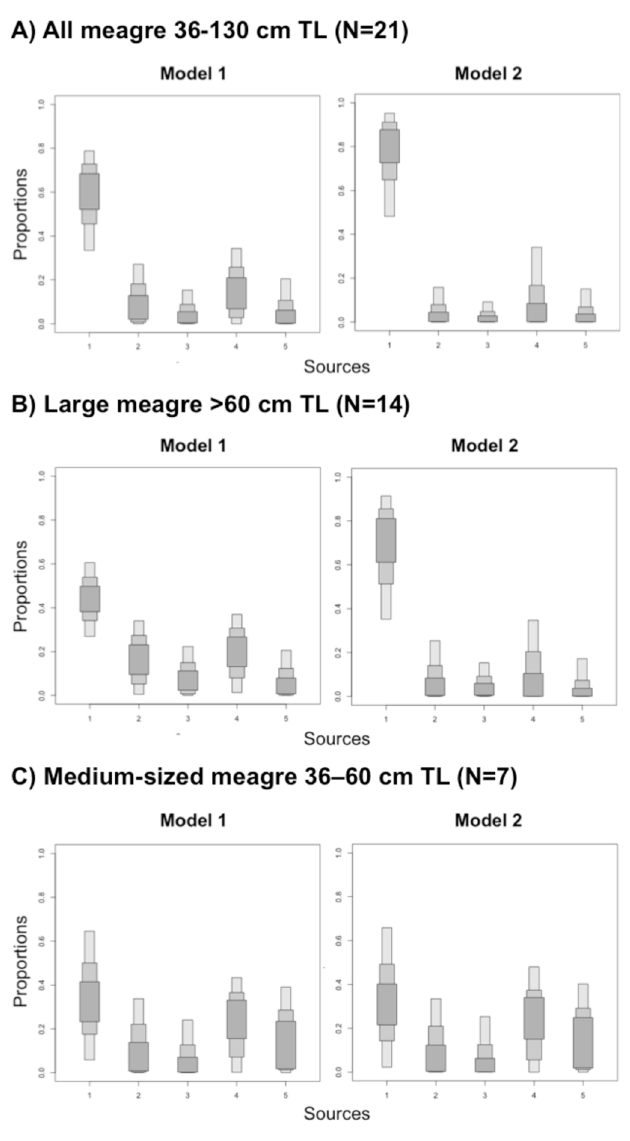
Fig. 5. Results of SIAR mixing models applied with different TEFs, showing the estimated proportions (with 50%, 75% and 95% con fi dence intervals) of each source/prey in the diet of meagre (size range =36 – 130 cm TL) collected in 2010 in the Bay of Biscay and analysed for SIA. Data corrected from the effect of ethanol preservation were used (see text and Supplemental Material). (A) Models applied on all individuals analysed for SIA ( N =21); (B) Models applied on large individuals only ( > 60 cm; N =14); Models applied on medium-sized individuals only (36 – 60 cm TL; N = 7). Prey groups (Spitz et al. , 2013): 1 =Pelagic fi sh; 2= Demersal and benthic fi sh; 3= Coastal fi sh; 4= Cephalopods; 5 =Crustaceans. TEFs: Model 1= 1.7± 1.1 ‰ for d 13 C and 3.2 ±1.3 ‰ for d 15 N (Sweeting et al., 2007a,b); Model 2= 2.5±0.1 ‰ for d 13 C and 3.3±0.2 ‰ for d 15 N (Pinnegar and Polunin